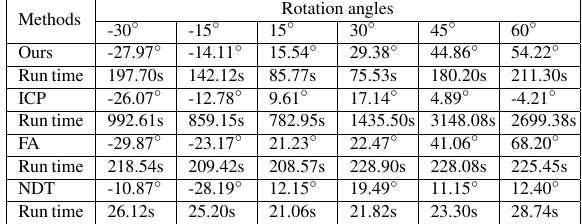
Table 3. Experimental results using manually rotated